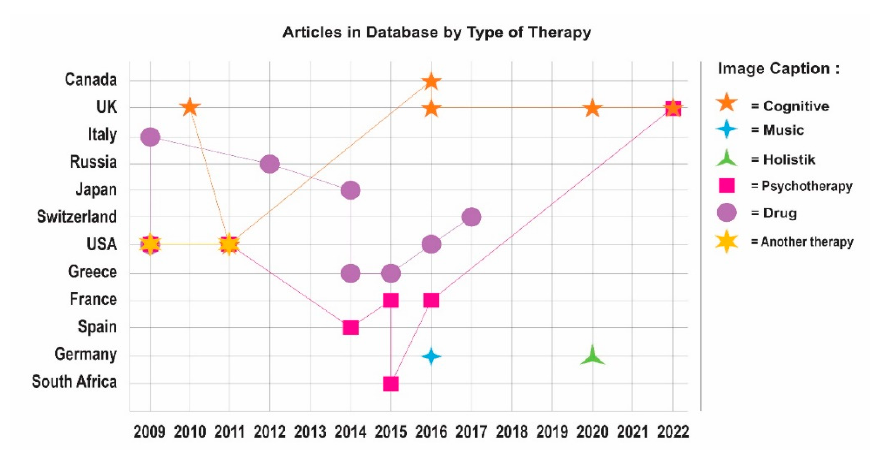
Figure 7. Number of articles from the database by type of therapy.